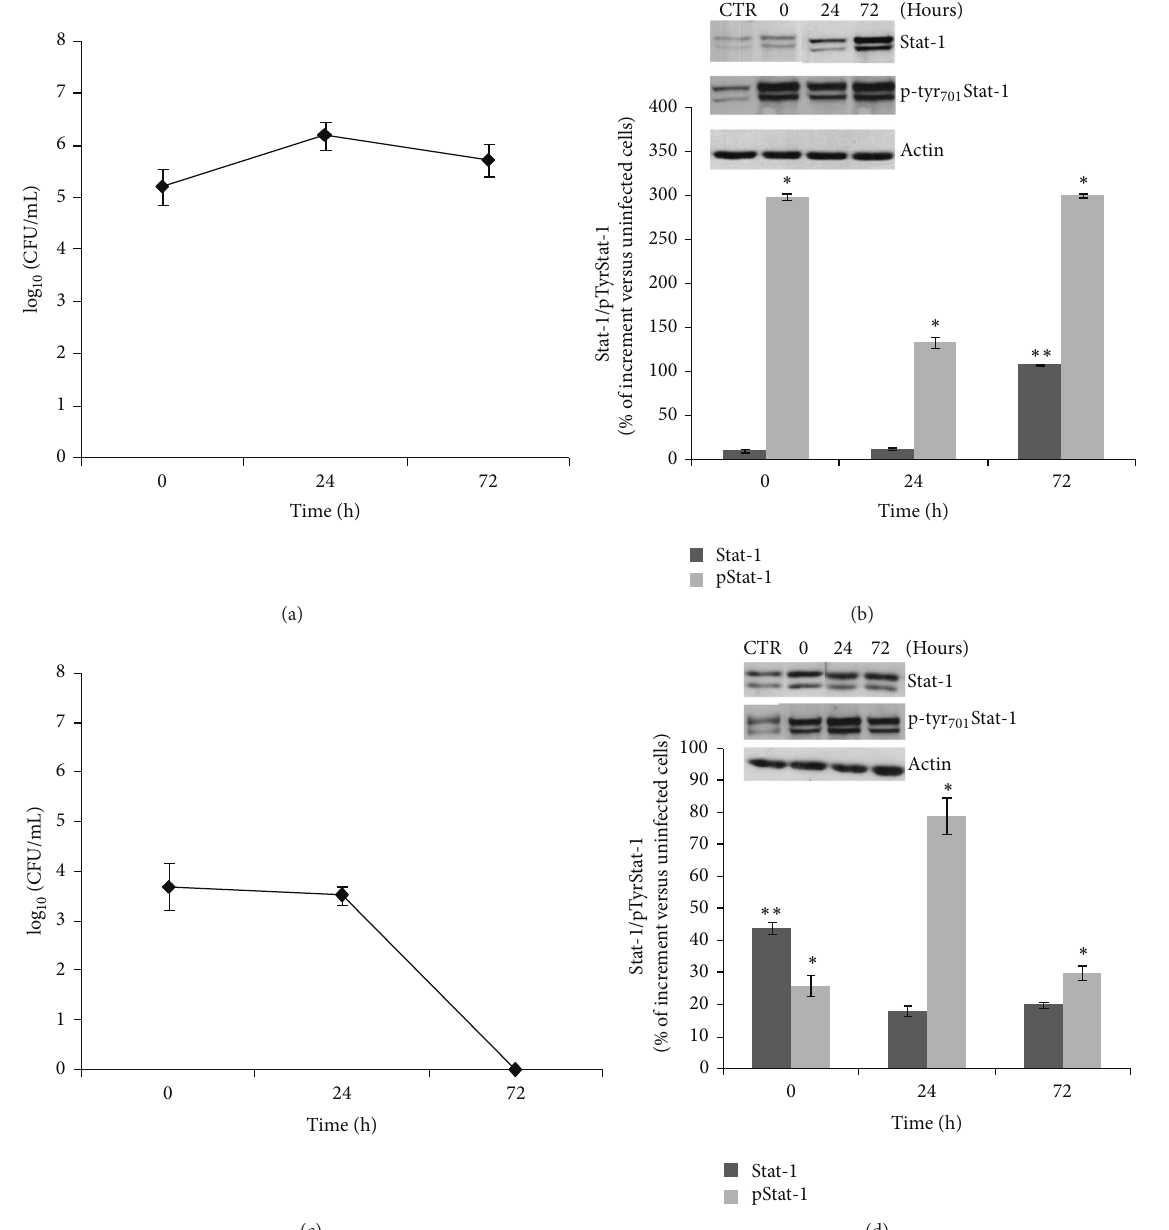
Figure 2: p-tyr 701 Stat-1 expression in human macrophages in response to Gram-negative bacterial infections. Ten-day-old macrophages were infectedwith Salmonellatyphimurium (a,b)or Legionellapneumophila (c,d).Afterremovingextracellularmicroorganisms,cellswereexposed for 30min to gentamicin to kill noningested bacteria and then cultured for an additional 3 days in fresh medium containing gentamicin. At the indicated time, the intracellular viable bacteria were determined by enumeration of CFU in specific medium ((a) and (c)), and data are the mean of three independent experiments ± SEM. Stat-1 and p-tyr 701 Stat-1 expression levels were evaluated by Western blot assay at the same times ((b) and (d)). Data were normalized on untreated (control) cells as a percentage increase. ∗ p-tyr 701 Stat- 1 expression levels are significant compared to control cells; ∗∗ Stat-1 expression levels are significant compared to control